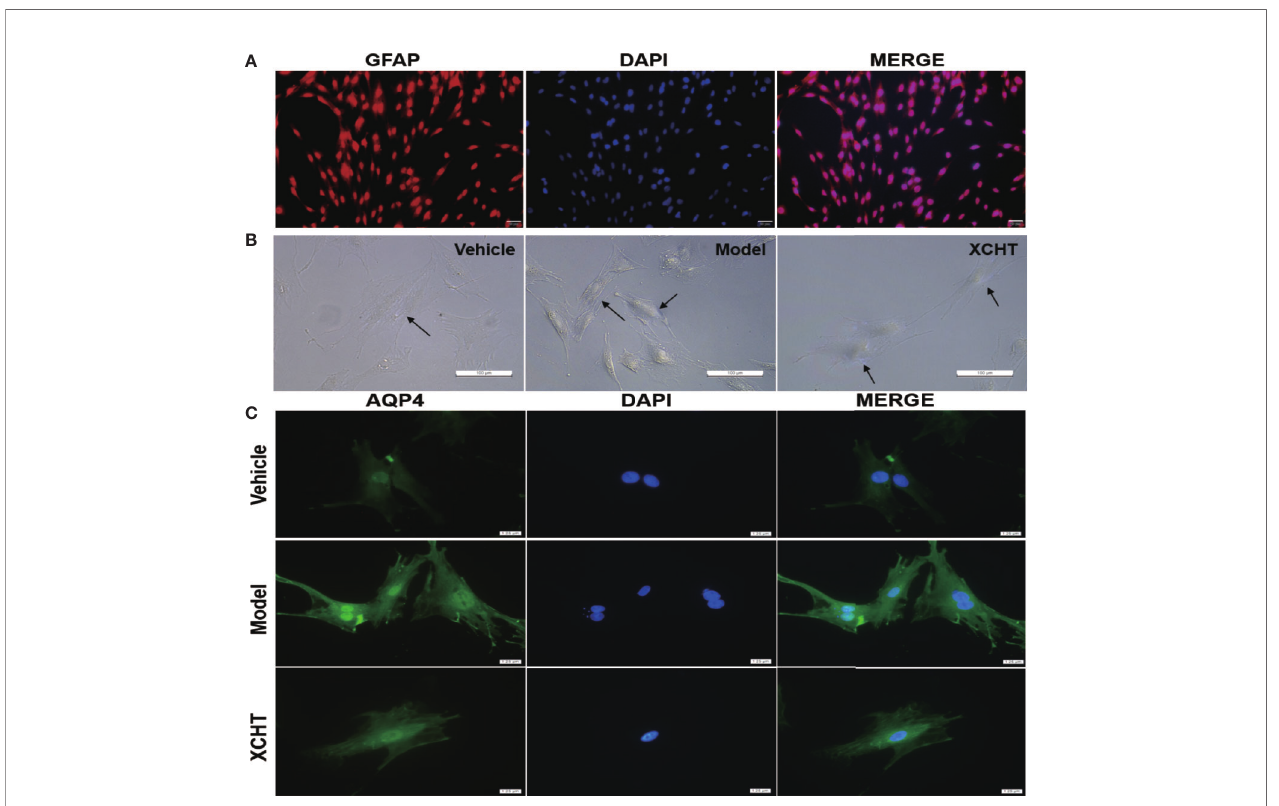
FIGURE 6 | Effect of XCHT compound serum on ammonia-induced astrocyte swelling. (A) Purity of primary astrocyte culture. Immunolabeling of primary rat astrocyte cultures with the markers GFAP (Red) revealed pure primary astrocyte culture. Nucleus were stained with 4 ′ ,6 ′ -diamidino-2-phenylindole (DAPI) (Blue). (Staining, 100×) (B) Morphological overview of astrocyte culture after treatment. (C) Immunolabeling of primary rat astrocyte cultures with the markers AQP4 (Green), Nucleus were stained with 4 ′ ,6 ′ -diamidino-2-phenylindole (DAPI)